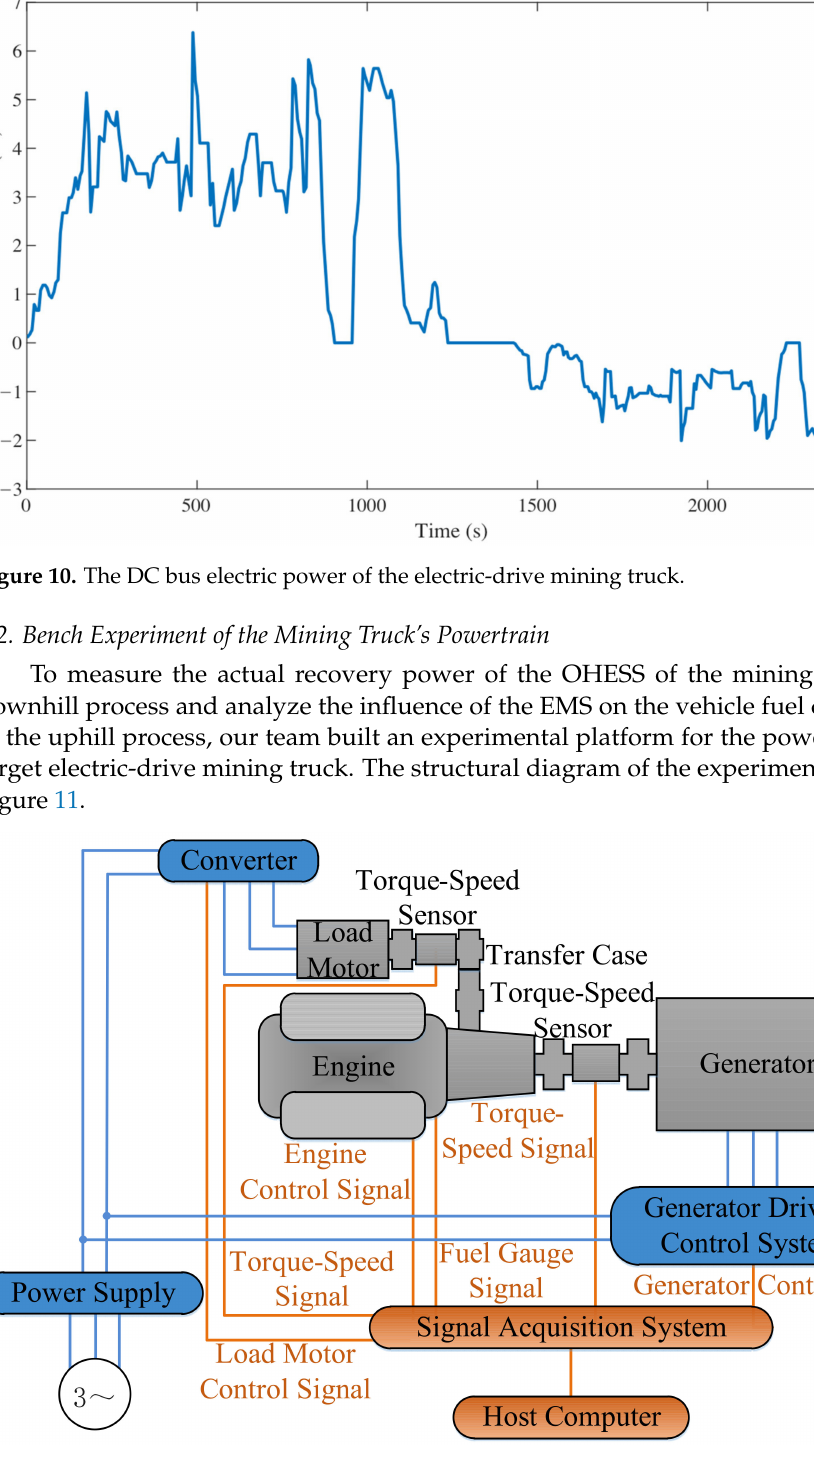
Figure 11. Bench experiment of the mining truck’s